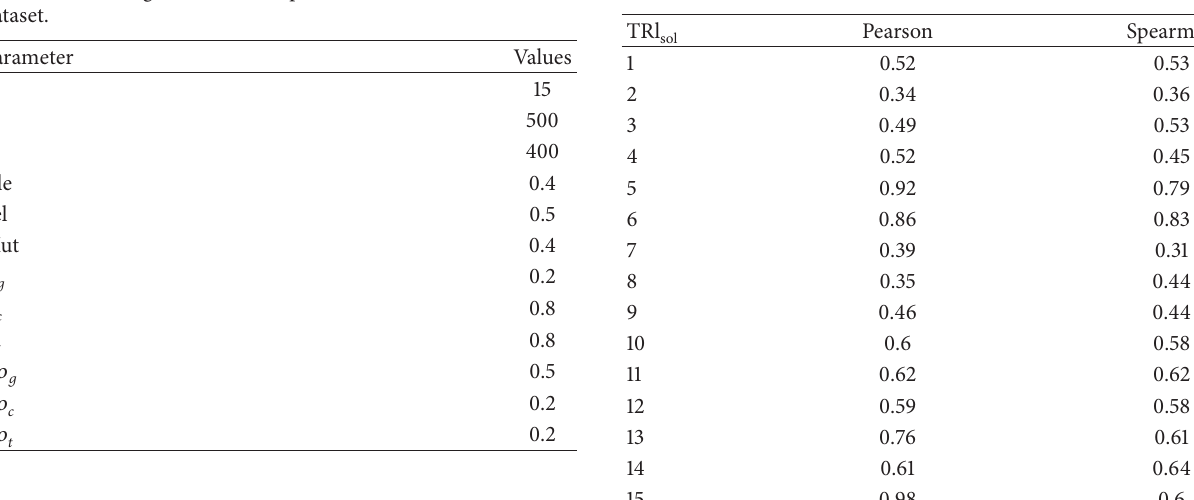
Table 10: Correlation results for tricluster Mouse GDS4442